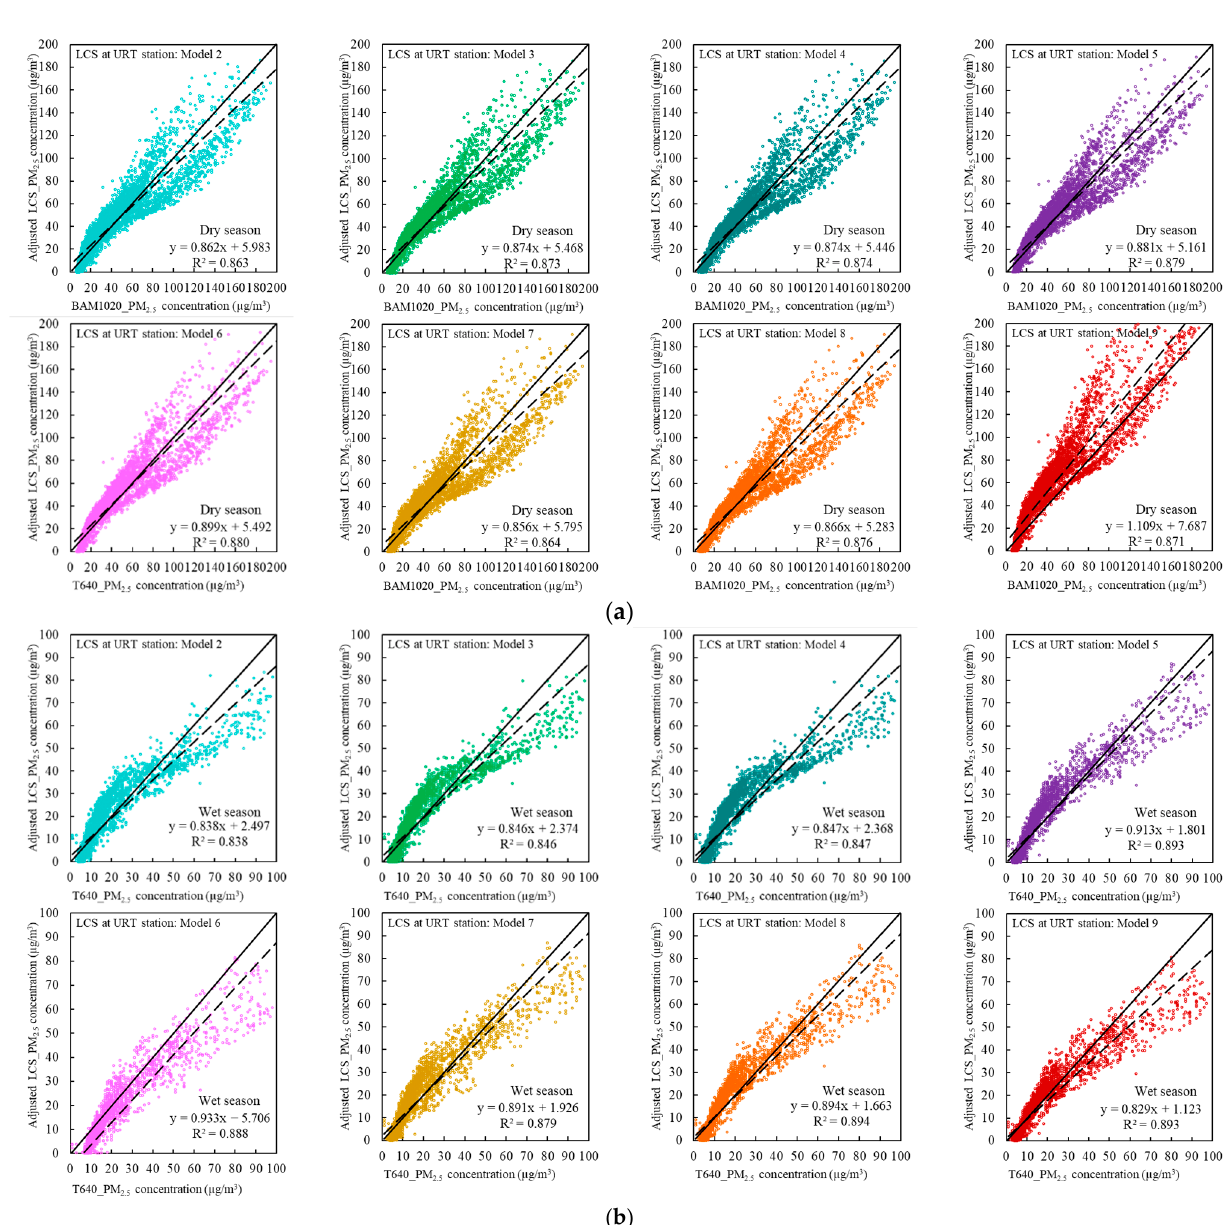
Figure A3. Correlation of 1-h PM 2.5 concentration between adjusted LCS by MRL models vs. FEM during the ( a ) dry and ( b ) wet seasons. The solid line is the line with slope =1 while the dashed line represents the fitting.